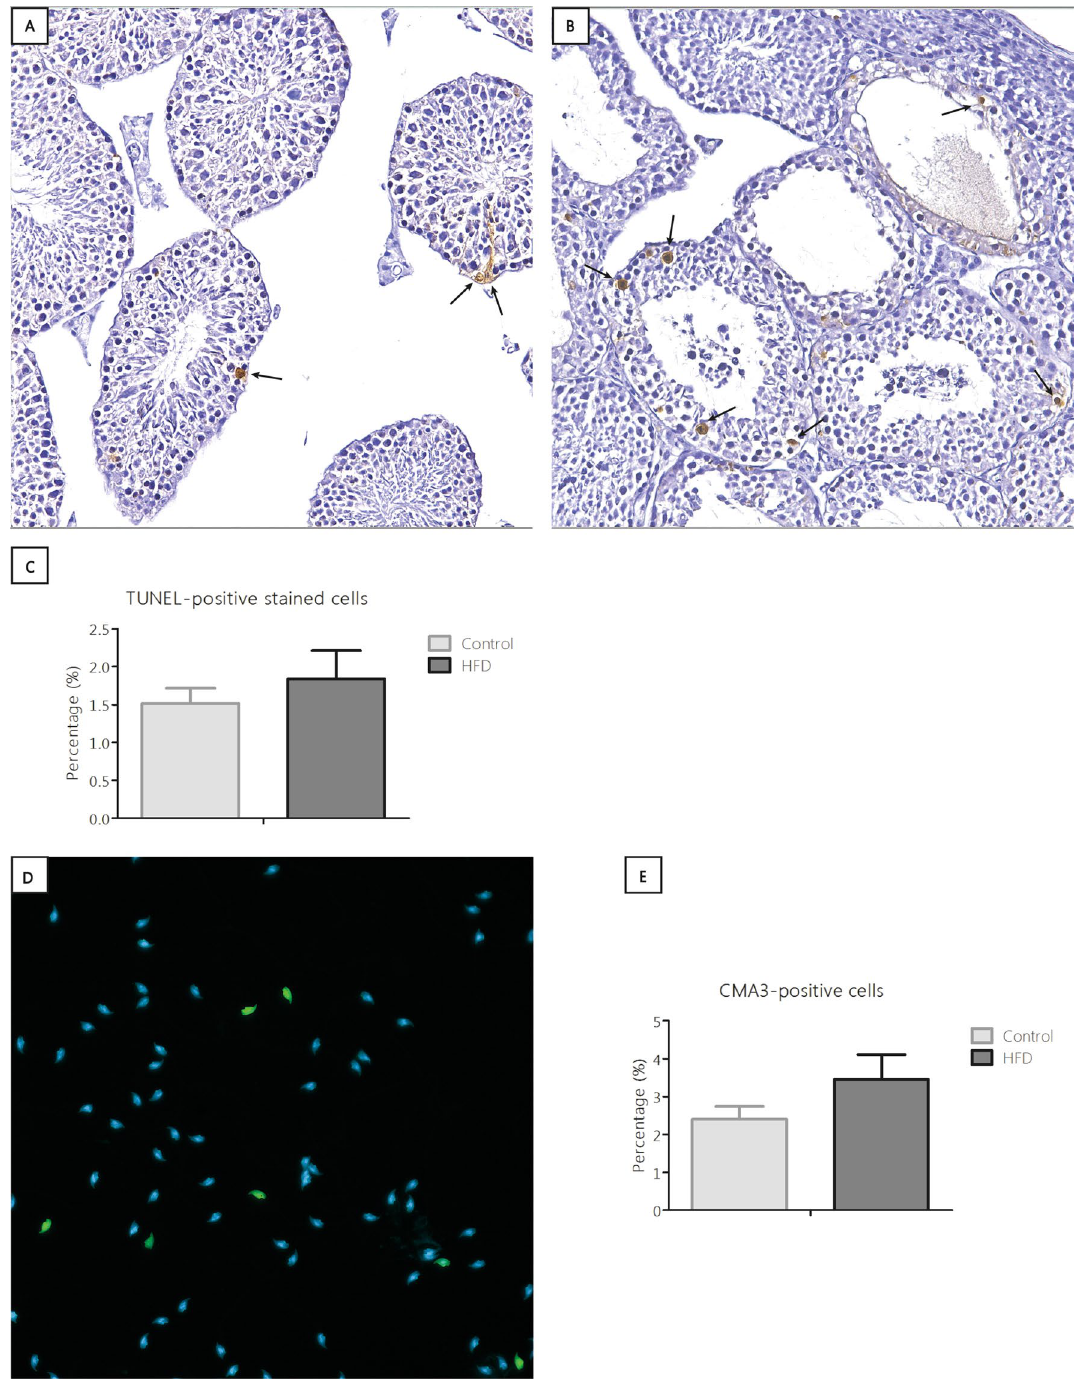
Figure 4. Analysis and representative images of the TUNEL and CMA3 staining. ( A ) Testis section with few TUNEL-positive cells (indicated with arrows). ( B ) Testis section with many TUNEL-positive cells. Original magnifications × 200. ( C ) Analysis of the percentage TUNEL-positive stained cells in the testes. Control n = 13. HFD n = 14. ( D ) Example of an overlay CMA3 staining with the CMA3-positive spermatozoa (green) and the CMA3-negative spermatozoa (DAPI, blue). See supplementary figure S3 for the separate channels of the overlay. ( E ) Analysis of the percentage CMA3-positive stained cells in the testes. Original magnifications × 400. HFD n = 9, Control n =